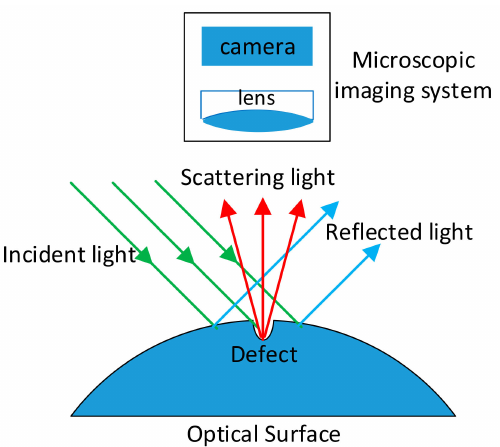
Figure 1. Schematic setup of the inspection system.